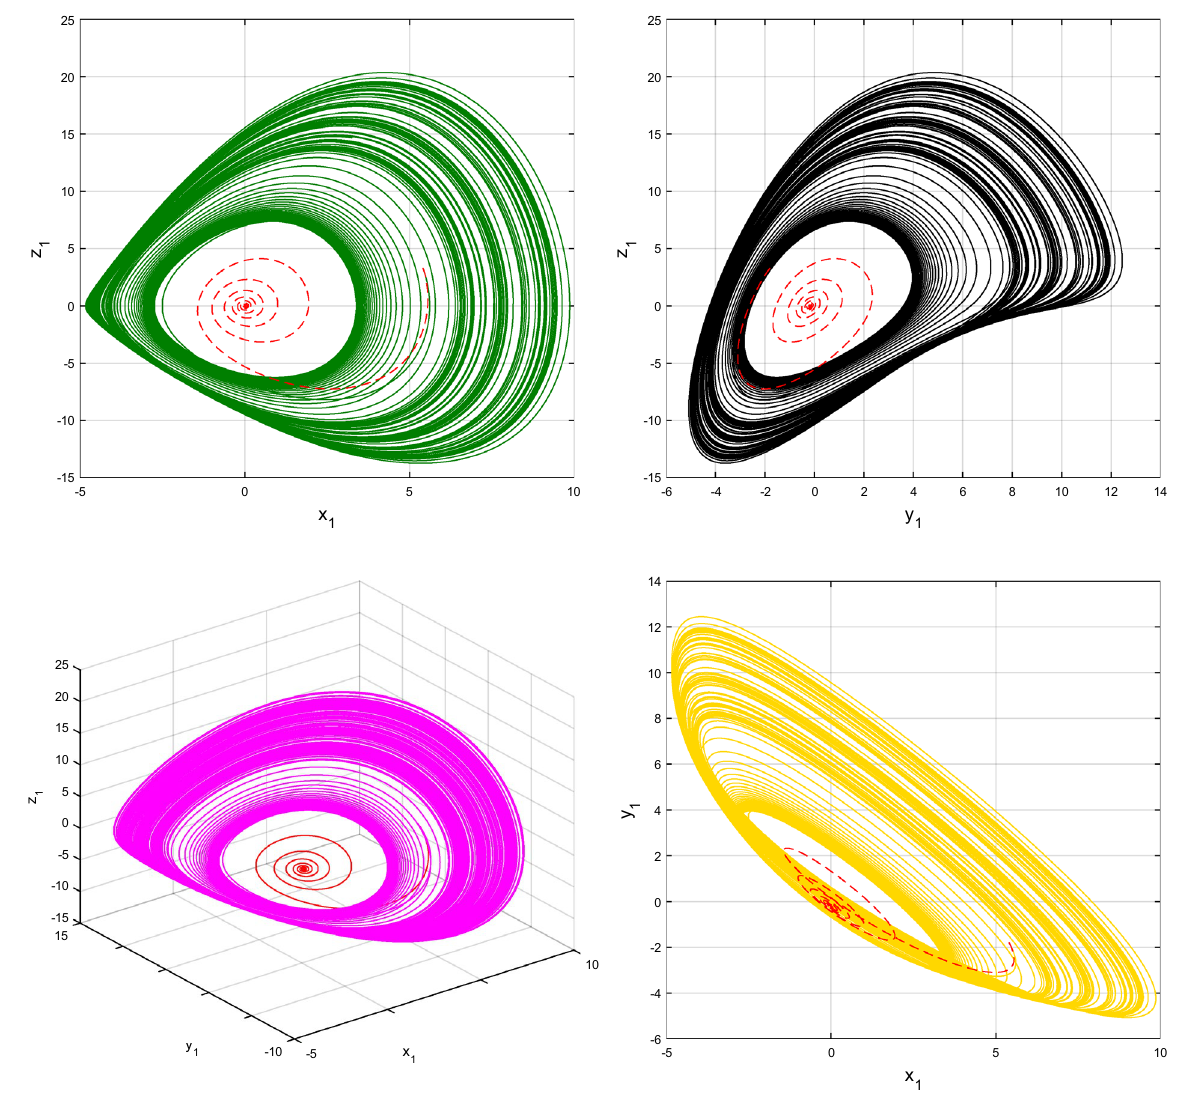
Figure 6. The case’s chaotic attractor dynamics, shown in 2D and 3D phase portraits when α = 1 (line) and α = 0.90